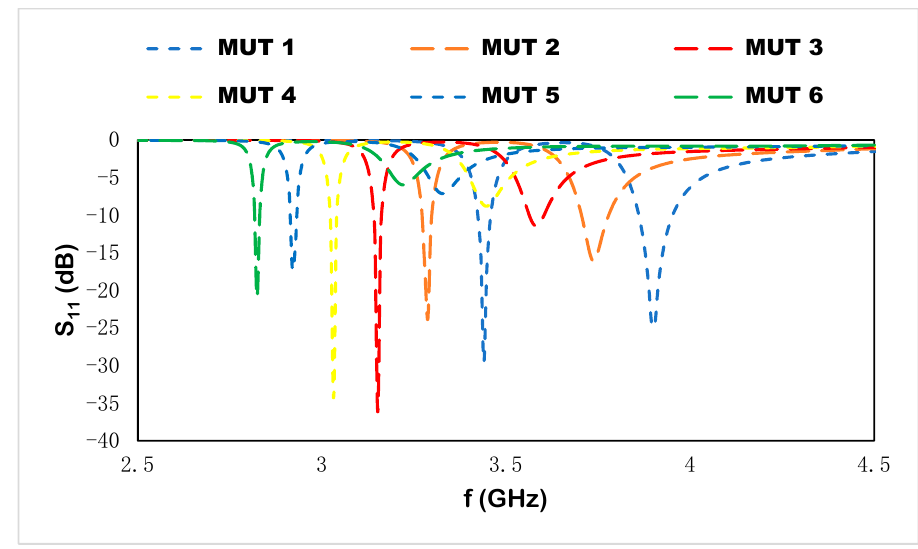
Figure 14. Reflection coefficient for different dielectric constants.